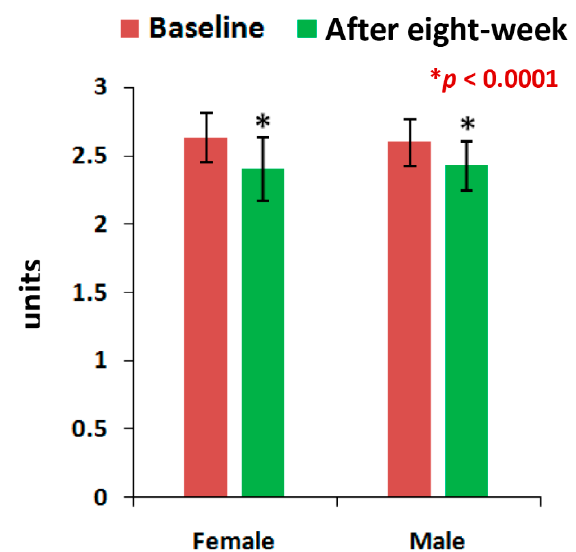
Figure 2. Levels of Calcium-to-Phosphorus ratio of 63 experimental subjects, female ( n = 39) and male ( n = 24), before and after eight-week using supplement (* p < 0.0001).